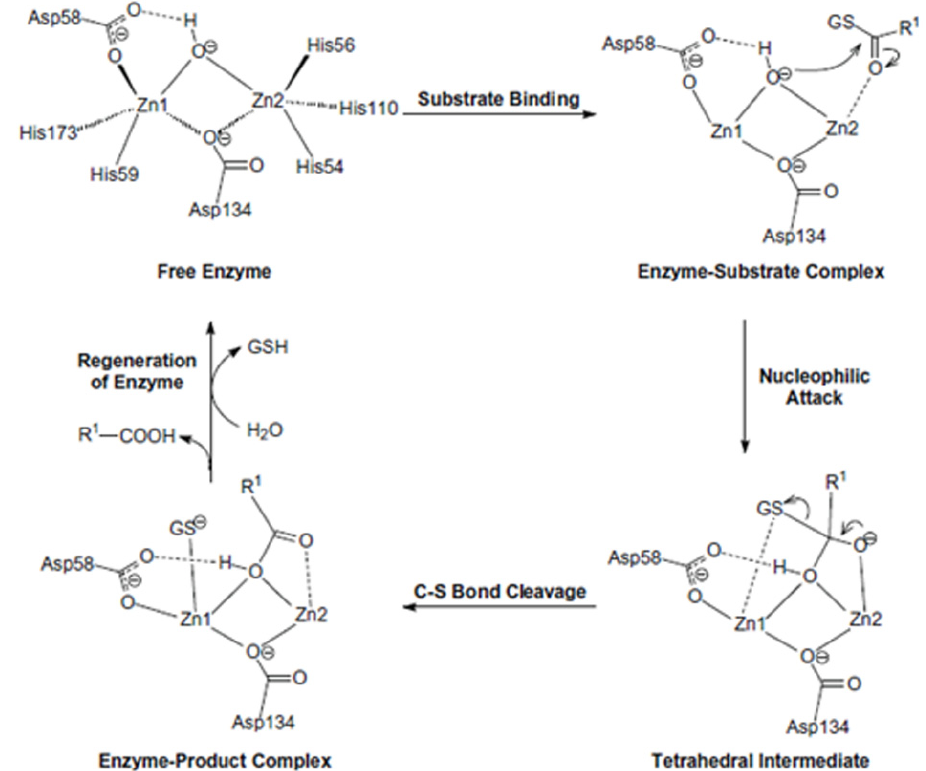
Figure 4. Proposed reaction mechanism for Glo2. Glo2 works via acid–base catalysis mediated by the nucleophile OH − that can be generated under physiological conditions. After SLG binding (substrate binding), the nucleophilic attack of OH - at the carbonyl carbon of lactoyl group of SLG takes place